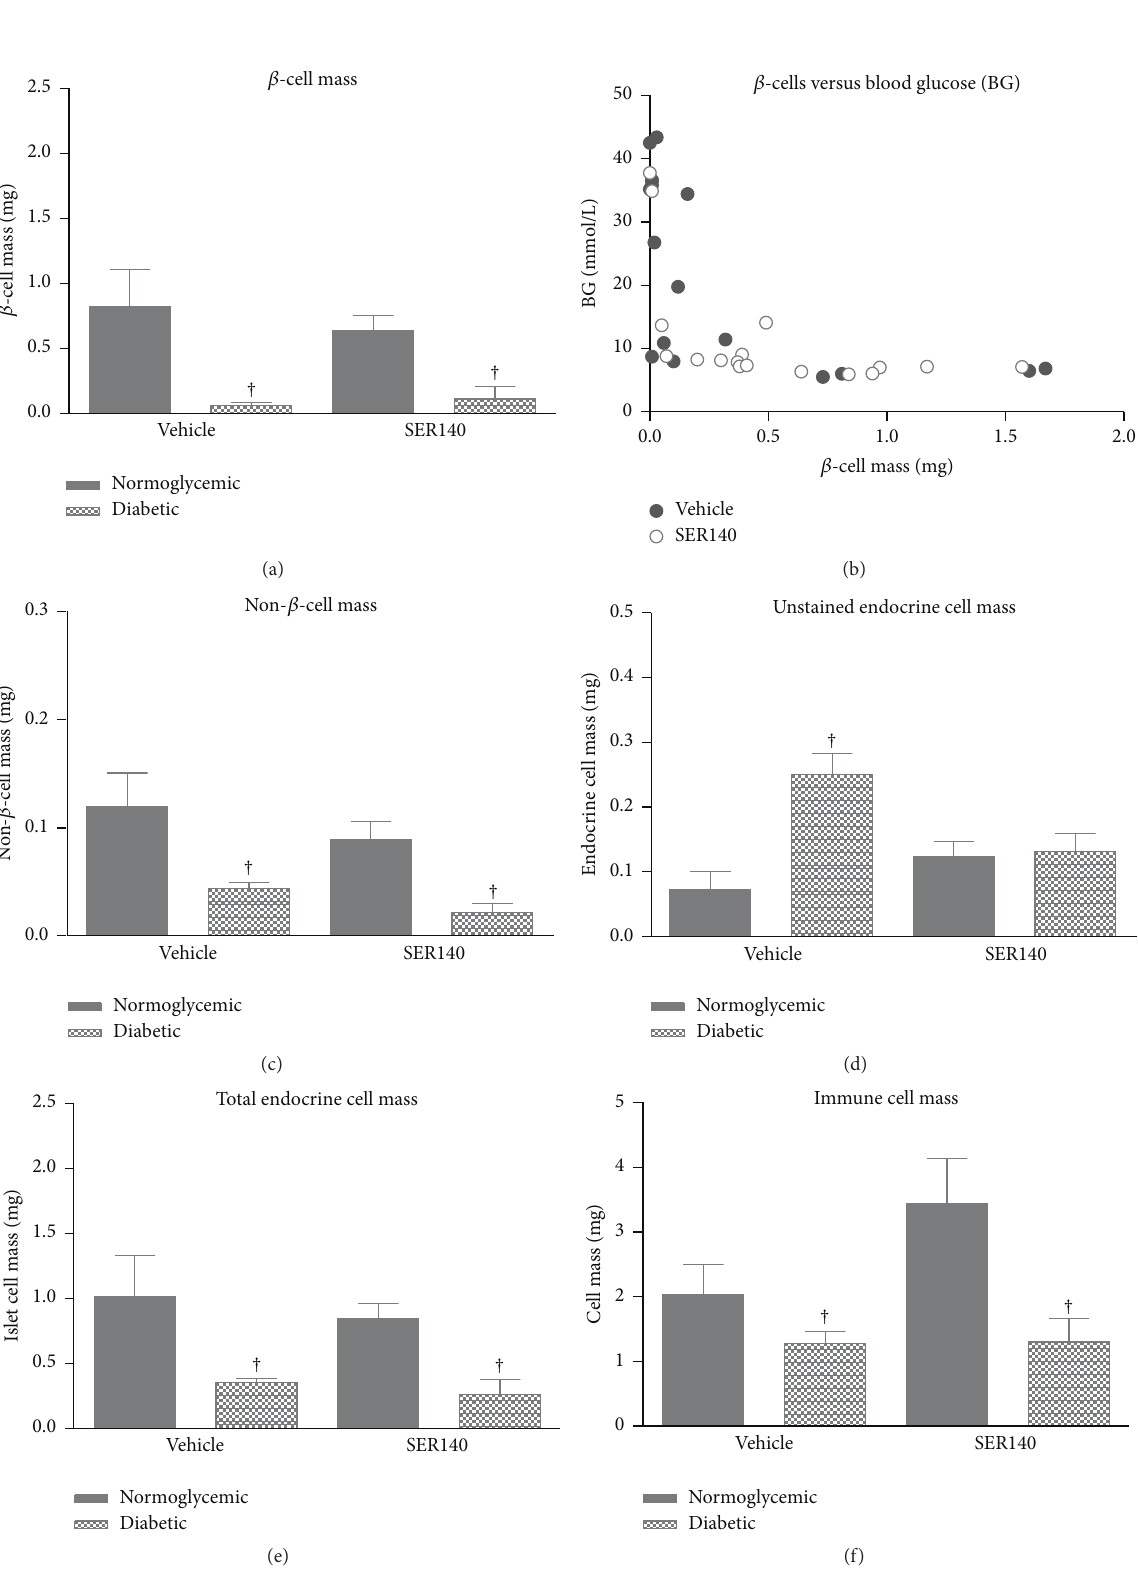
Figure 6: Stereological analyses of nondiabetic and diabetic NOD mice pancreata. (a) 𝛽 -cell mass, (b) 𝛽 -cell mass versus BG, (c) non- 𝛽 - cell mass, (d) unstained endocrine cell mass, and (e) immune cell mass in diabetic and nondiabetic vehicle and SER140 treated NOD mice. (f) 𝛽 -cell mass versus immune cell mass. ((a), (c), (d), and (e)) Data are presented as mean ± SEM ( 𝑛 = 18-19/group); one-way ANOVA with Turkey’s multiple comparison test; † 𝑝 < 0.05 versus vehicle normoglycemic